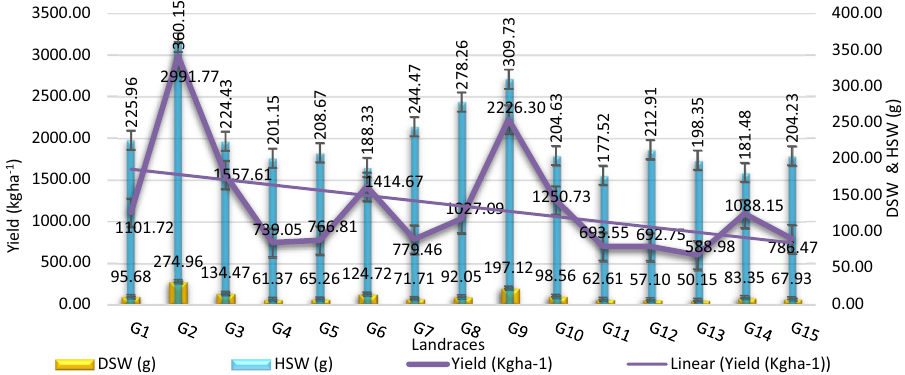
Figure 3. Graphical relationship of dry seed weight (DSW) and hundred seed weight (HSW) with yield (kg ha −1 ) for Bambara groundnut